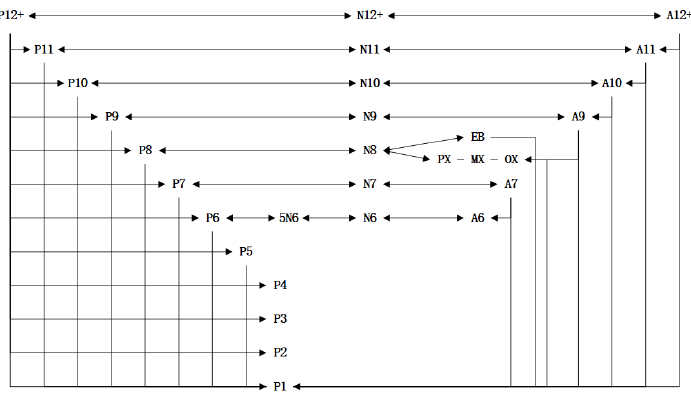
Figure 1. The 34-component lumped reaction